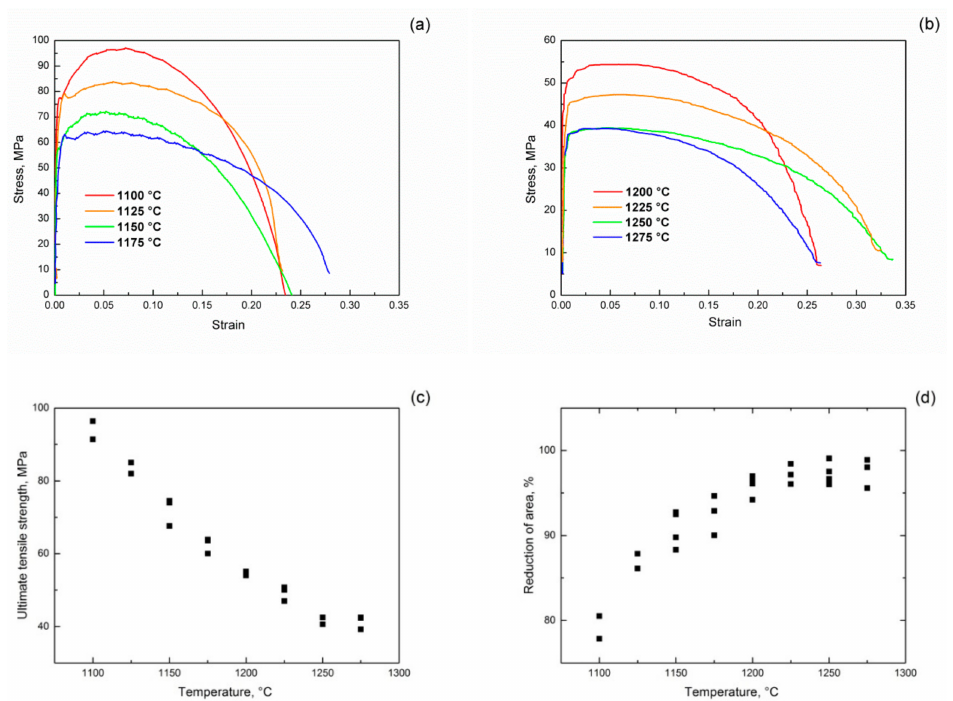
Figure 7. Hot tension curves ( a , b ), ultimate tensile strength ( c ) and reduction of area ( d ) of 13CrMoNbV steel at temperatures in the range of 1100–1275 ◦